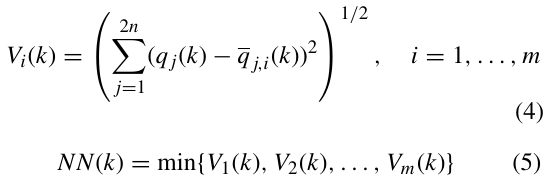
case) with the least Euclidean distance V i ( k ) to the query point, obtained after preprocessing the state of the walker with equation 1, q ( k ) = q j ( k ), j = 1 , . . . , 2 n , (4),